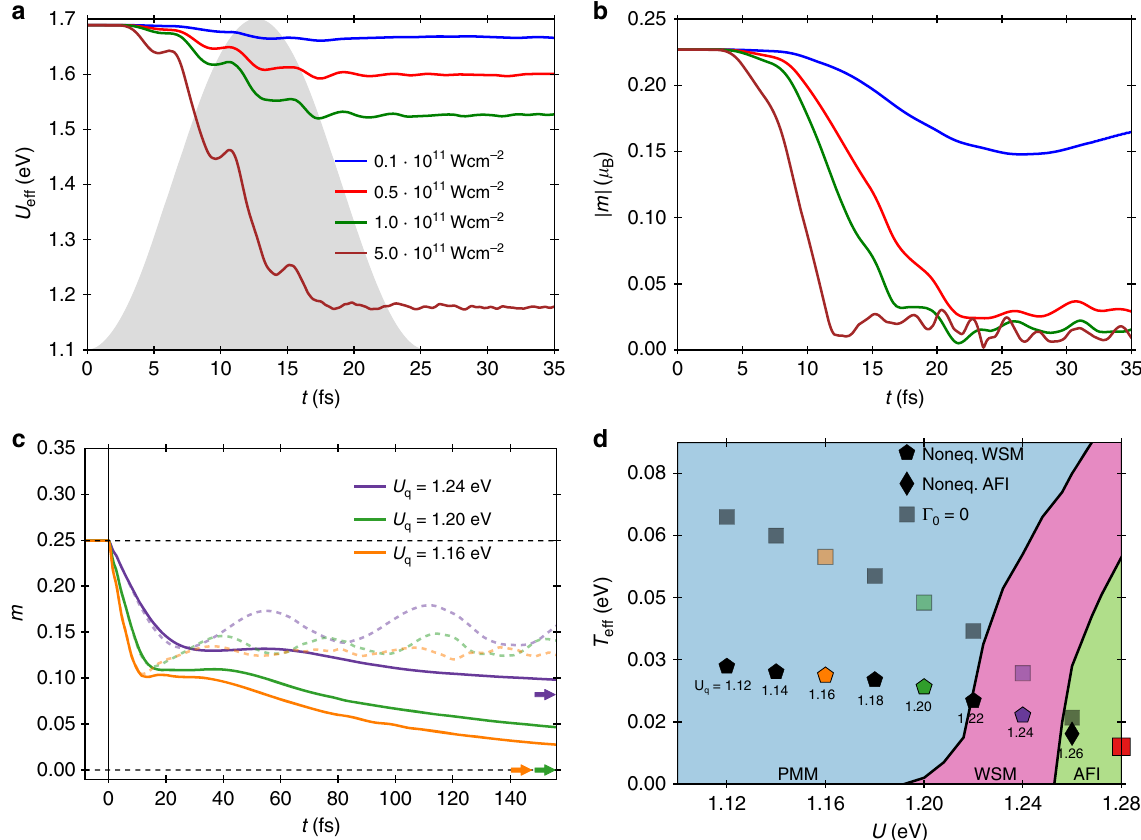
Fig. 2 Optically induced nonthermal Weyl semimetal. a Self-consistent TDDFT + U calculation of U eff ( t ) (Ir 5 d ) for Y 2 Ir 2 O 7 under pump excitation (0.41 eV frequency, 25.4 fs duration). U eff decreases, initially following the pulse envelope. After 20 fs it reaches a plateau, which decreases for higher intensities. Relative changes of U eff are 1.2% (blue), 5.3% (green), 9.6% (red) and 40.4% (cyan). b Time-dependent AIAO magnetisation from TDDFT + U. For the smallest intensity (blue) the magnetisation drops by 25%. For all higher pump intensities, there is a massive decrease of the magnetisation by 88% (red) and 92% (green, brown), respectively. c Time-dependent AIAO magnetisation m ( t ) (model) for bath coupling Γ 0 = 0.008 eV after instantaneous quenches at t = 0 from U i = 1.28 eV to U q = 1.24, 1.20 and 1.16 eV, respectively (dashed curves are without bath, Γ 0 = 0). Thermal m values for U q are indicated by coloured arrows for reference. After a fast drop followed by an over-damped oscillation, the magnetisation slowly converges towards the respective thermal value. d Equilibrium phase diagram as a function of T and U with optically induced nonthermal states. Effective temperatures T eff (see Supplementary Fig. 3) of the nonequilibrium states at t p = 123.4 fs after the quench from the initial thermal state (red square), for quench values U q as indicated (see Supplementary Fig. 2). Pentagons (squares) indicate nonequilibrium WSM states for the open system (closed system). (see Fig. 3). The black diamond indicates a nonequilibrium AFI